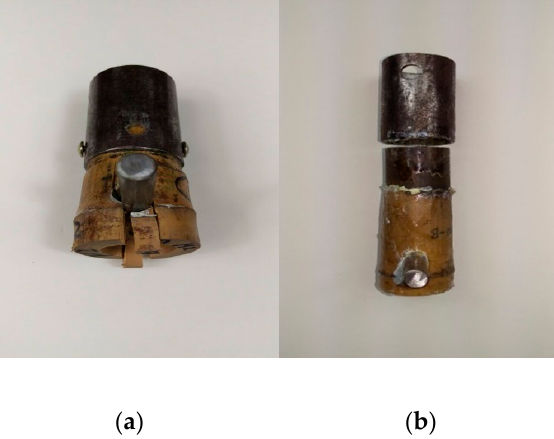
Figure 9. Bamboo failure ( a ) and adhesive failure ( b ) of sleeved Gui bamboo joints.